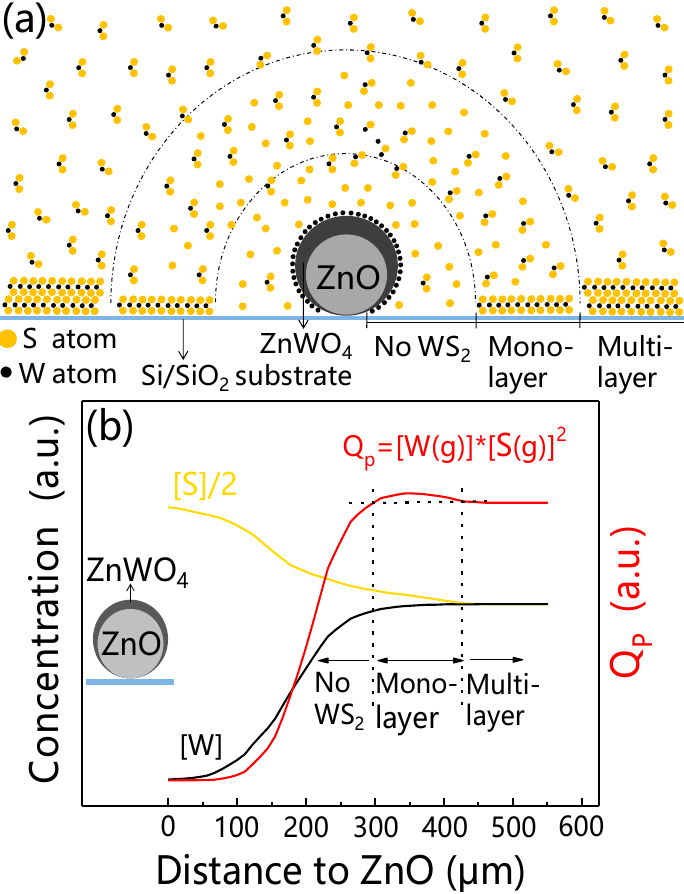
Figure 7. ( a ) Schematic diagram of W and S distribution around ZnO crystal whisker. ( b ) Distance dependence of W atom concentration, S atom concentration, and the reaction quotient (Q P ). The direction of the horizontal axis is perpendicular to the growth axis of ZnO whisker. The coordinate of the ZnO whisker on the horizontal axis is zero. [W] and [S] represent W and S atom concentration in ( b ), respectively.